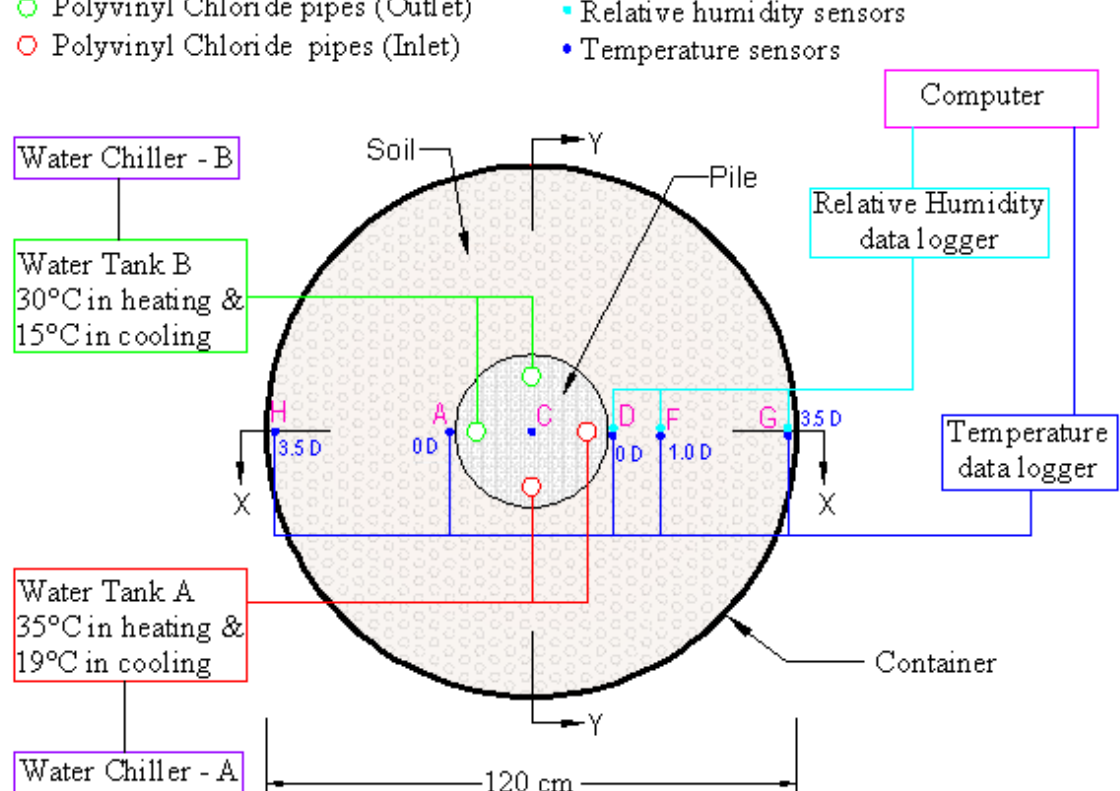
Figure 6. Experimental test setup schematics (drawn not to scale).